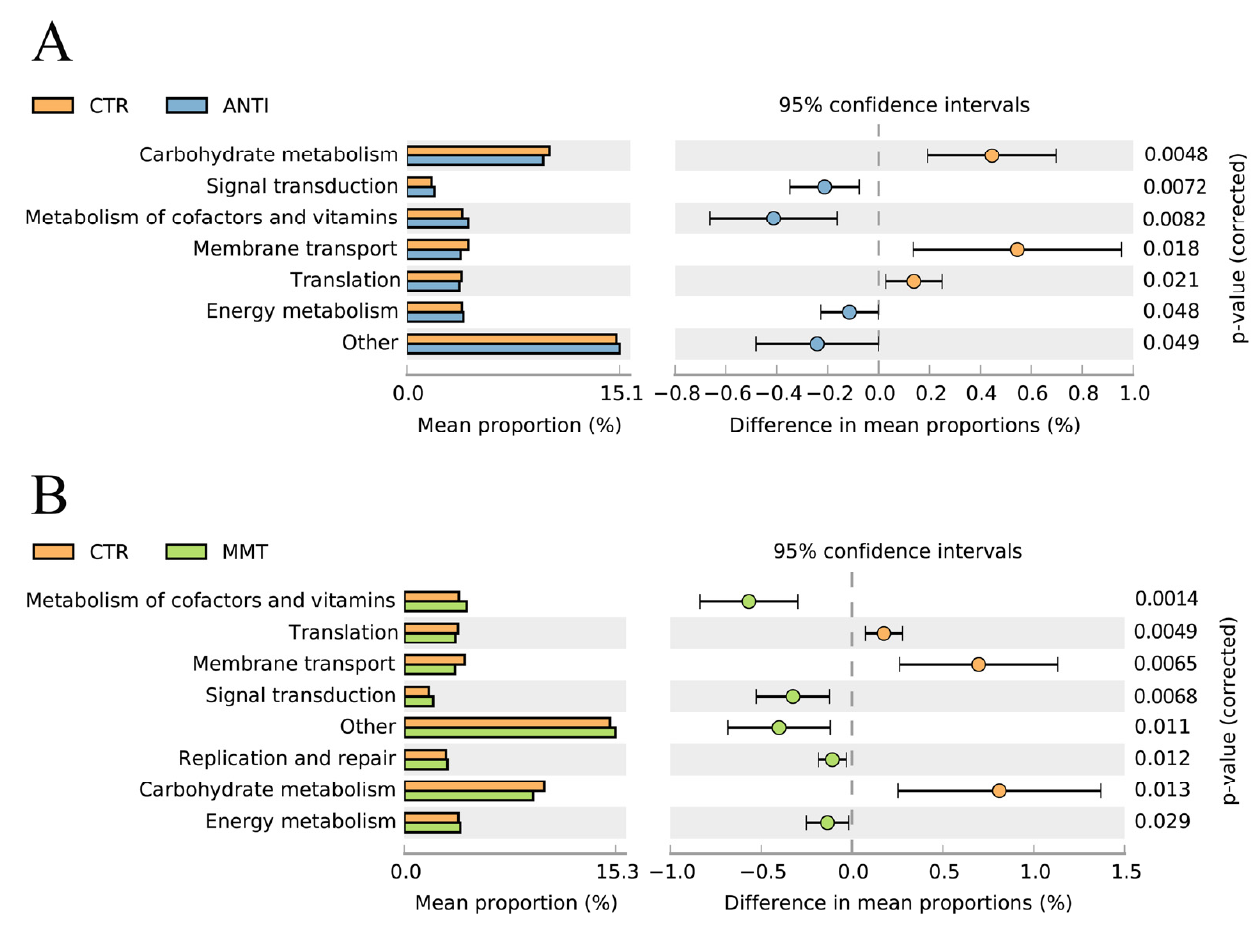
Figure 4. Comparison to predicted metabolic pathway abundance between the groups by statistical analysis of taxonomic and functional profiles (STAMP) at Level 2: ( A ) CTR vs. ANTI; ( B ) CTR vs. MMT.